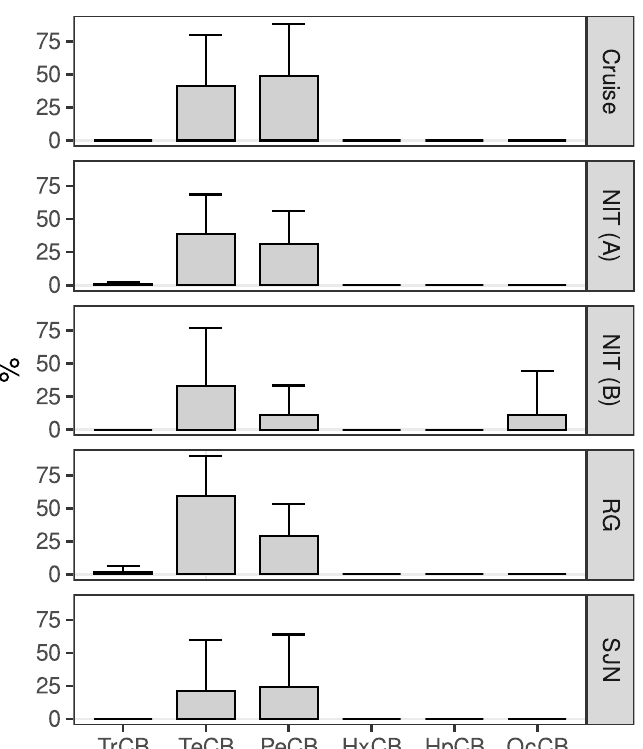
Figure A1. Mean and standard deviations for the relative distribution (%) of PCBs by chlorination level in Sardinella brasiliensis muscle tissue obtained during five different sampling campaigns carried out in Brazil. The PCB nomenclature reflects their chlorination level [31]. Table A1. Summary for the concentration of Σ 41 PCBs in Sardinella brasiliensis muscle tissue